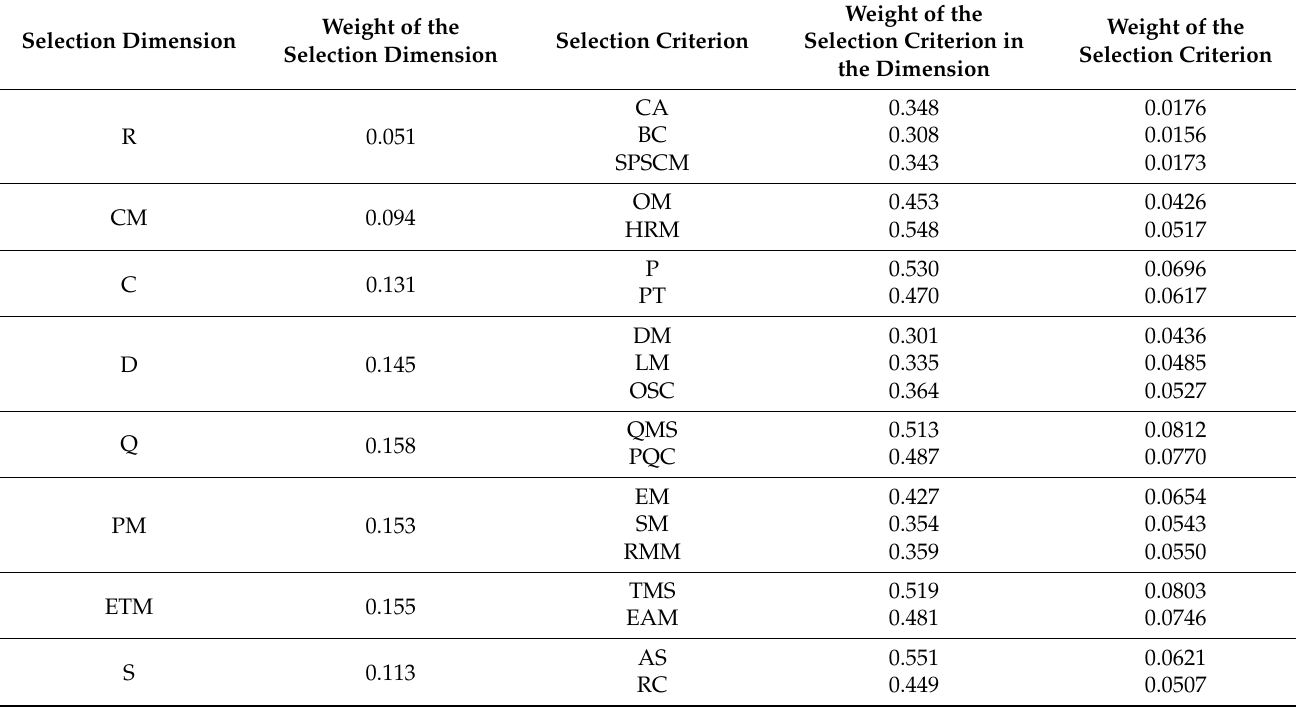
Table 4. Relative weights of the selection dimensions and